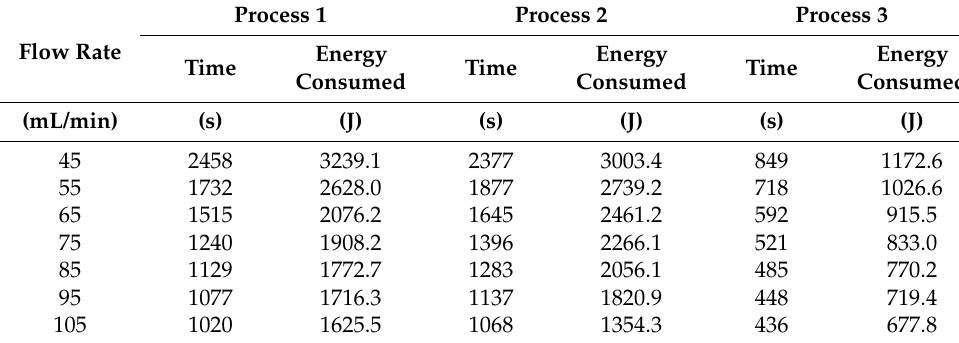
Figure 5. Current versus time curve of absorption–desorption cycles of the CDI (NaCl 0.4 M, 1.2 V, 75 mL/min) for three types of processes: ( a ) Process 1, ( b ) Process 2, and ( c ) Process 3. Table 3. Time and energy consumed for various flow rates using three different types of processes (NaCl 0.4 M, 1.2